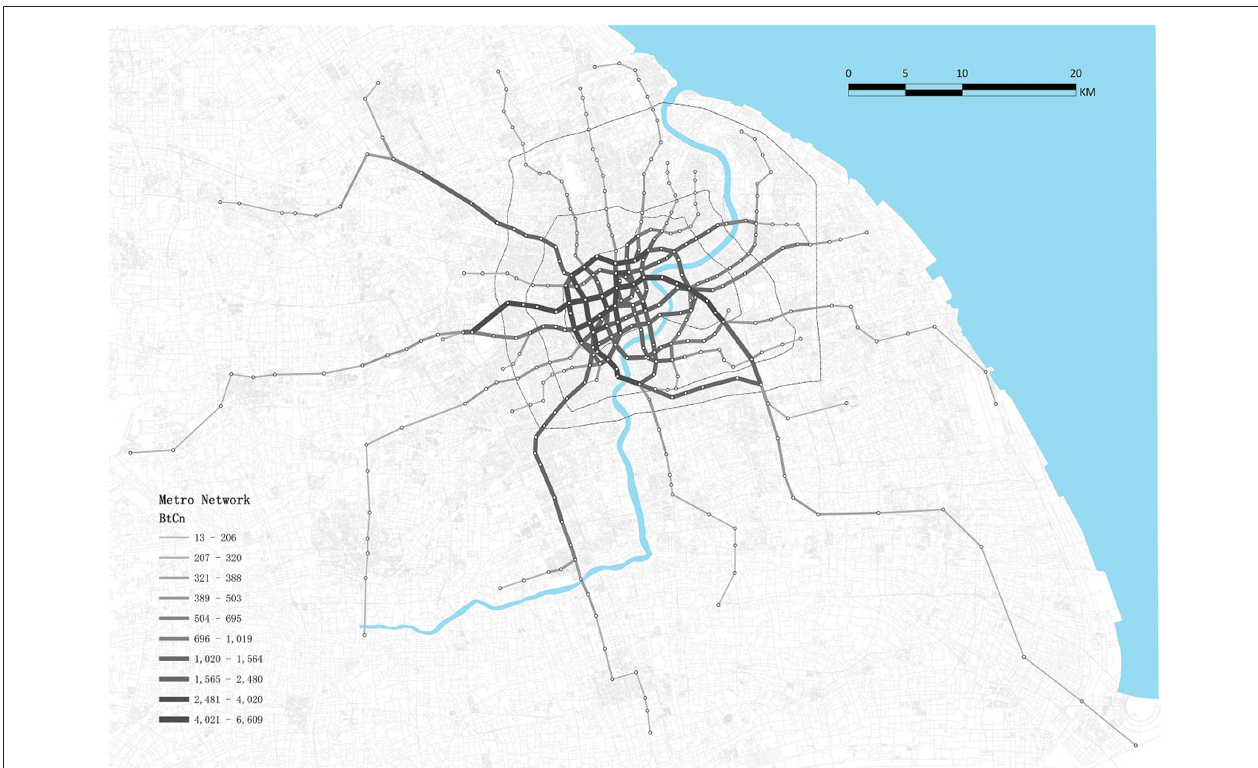
FIGURE 3 | Betweenness centrality of Shanghai metro